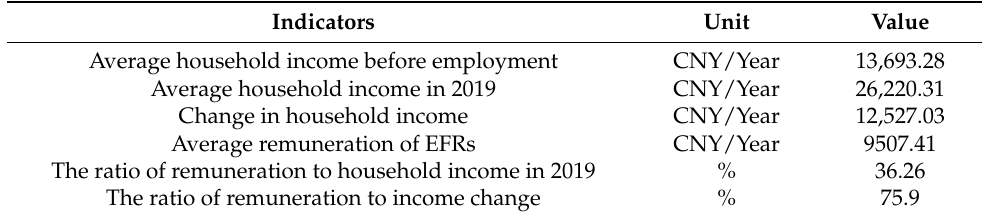
Table 4. Change in household income and remuneration of